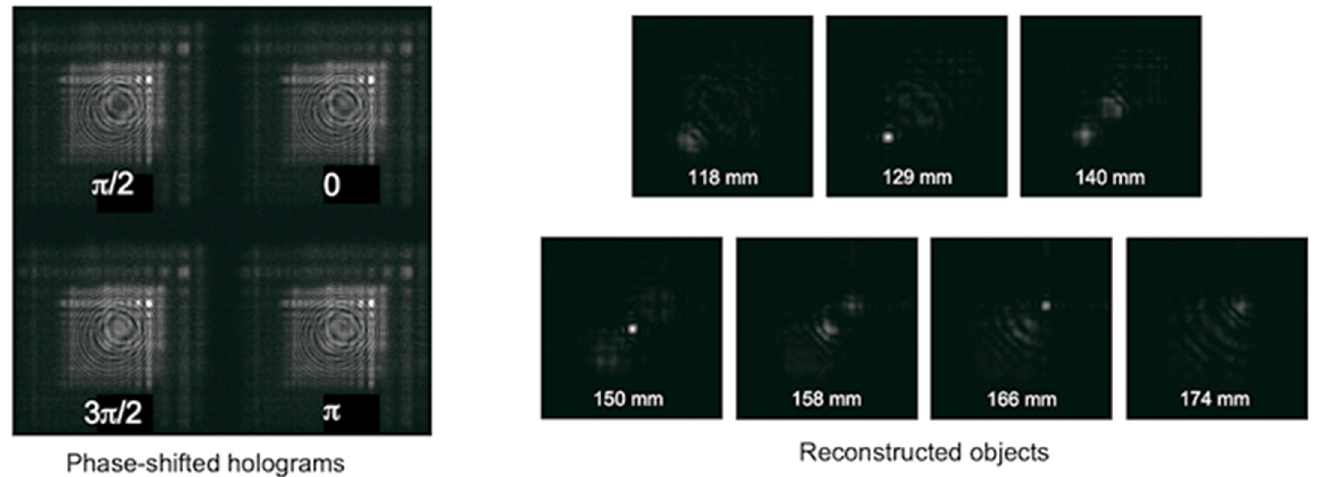
Figure 6. Obtained four phase-shifted holograms and reconstructed images at different axial positions.